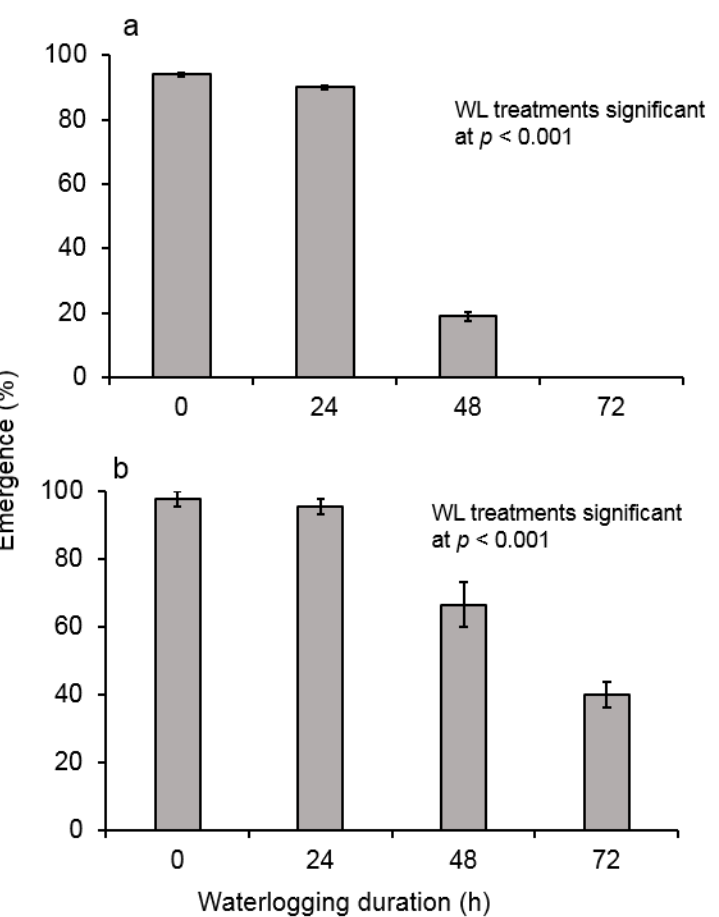
Figure 2. Emergence percentage of sunflower under different waterlogging treatments for ( a ) early sowing and ( b ) late sowing. Vertical bars in each graph indicate the standard error of the means. Values are means of three replications. WL indicates waterlogging.